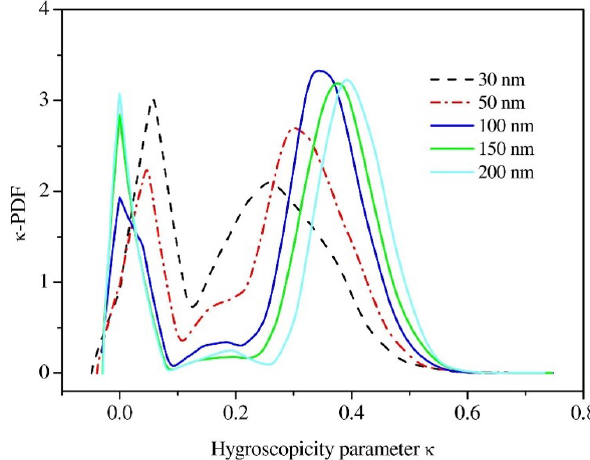
Figure 4. Probability distribution functions of the hygroscopicity parameter ( κ ) for 30, 50, 100, 150 and 200nm aerosols at the Pudong site in September 2009. Reprint with permission by Ye et al. (2013). Copyright 2013 Elsevier